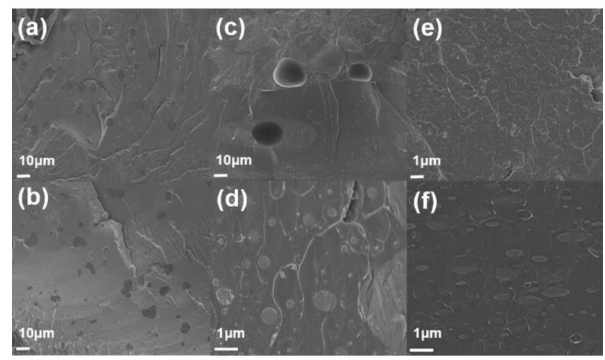
Figure 7. The SEM cross-section images of the PMMA / PS blends: ( a , b ) PMMA / PS(10 / 90),